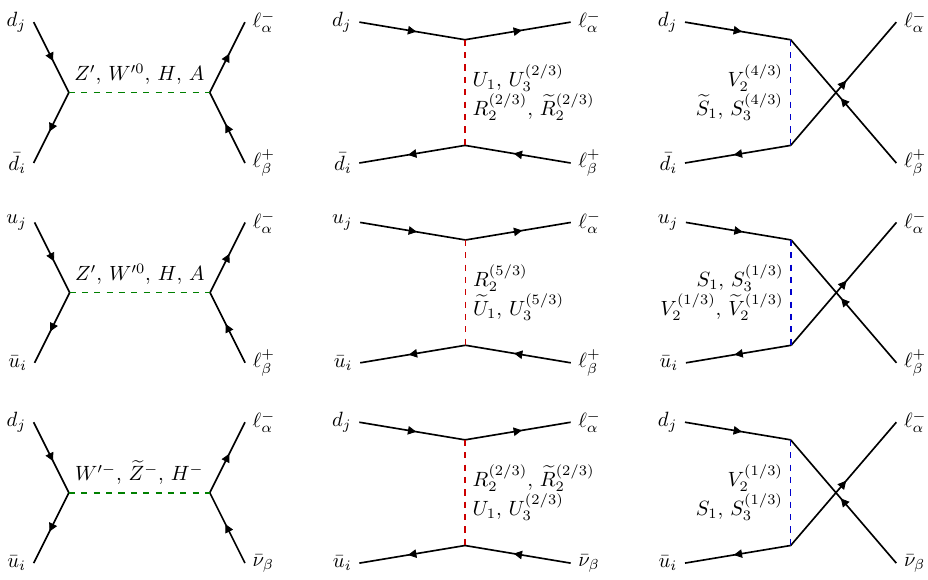
¯ Figure 3. Contributions to dilepton transitions dd → ‘ − ‘ + (upper row), ¯ uu → ‘ − ‘ + (middle row) and ¯ ud → ‘ ± ν (lower row), from the tree-level exchange of the BSM mediators displayed in table 2 via the s -channel (left column), t -channel (middle column) and u -channel (right